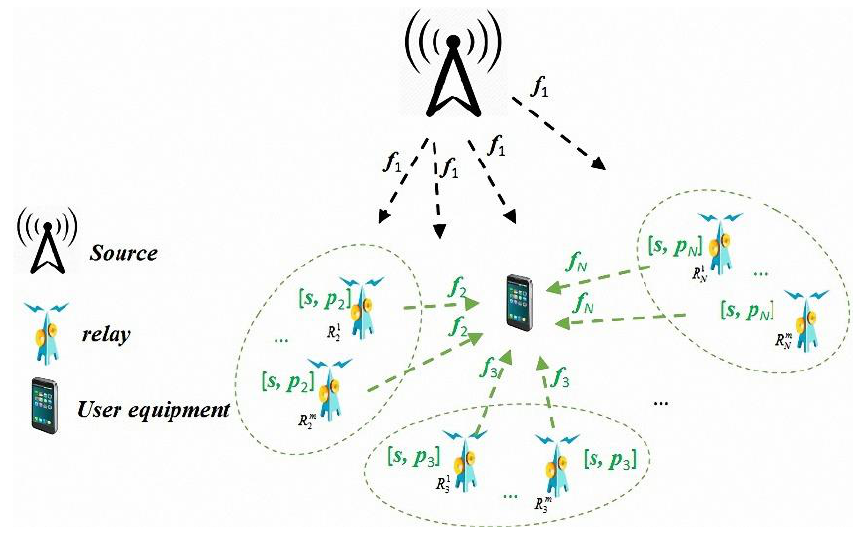
Figure 1. The concept of the relay-based cooperative network [16]. In [16] the authors proposed a grouping method named the “all frequency allocated grouping method”. The STC can be performed for user equipment in the case of receiving both signals coming from the STC pair stations of the same group. In Figure 1, if there are ( N − 1) frequencies available for the terrestrial stations(relays), all the stations are divided into ( N − 1) groups. Each group is assumed to consist of two stations and both two stations transmit signals in the same frequency. Regarding the environment, the channel propagation path loss and fading between each station and the user will be taken into account in this paper. The propagation path loss L ij is defined as the power law of the distance between the i -th station and the j -th user.